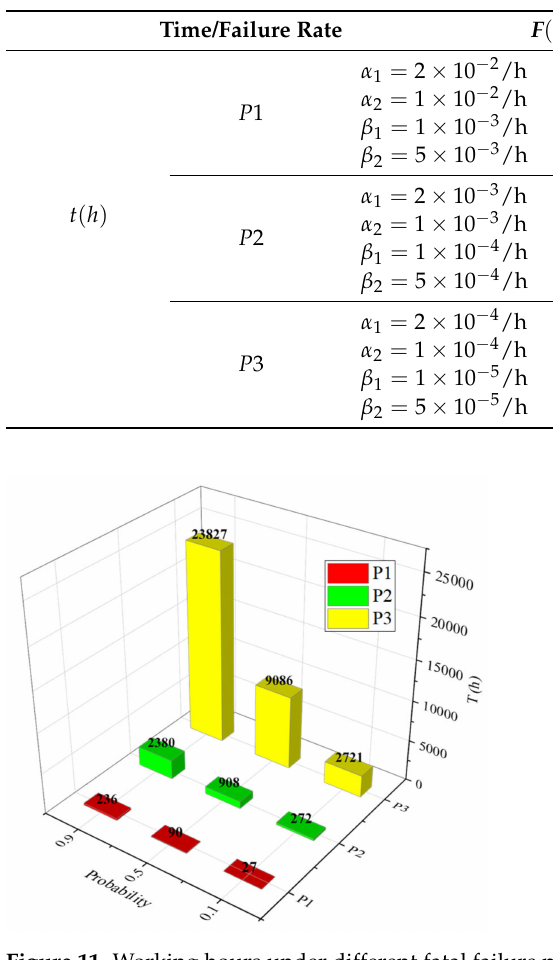
Figure 11. Working hours under different fatal failure